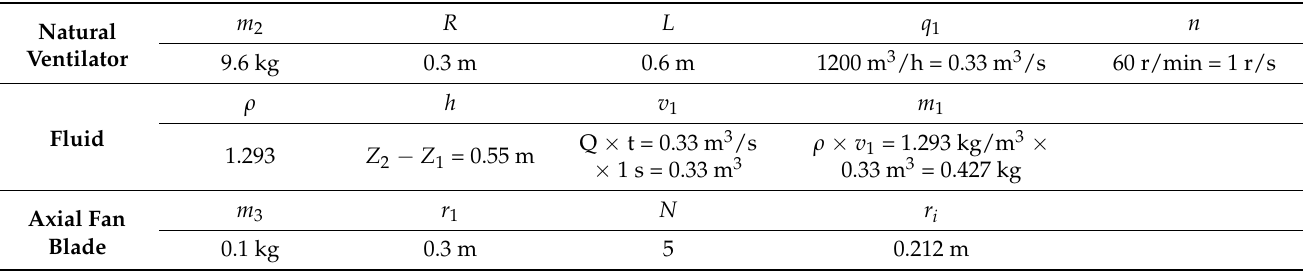
Table 7. Relevant parameters. The parameters of calculating energy